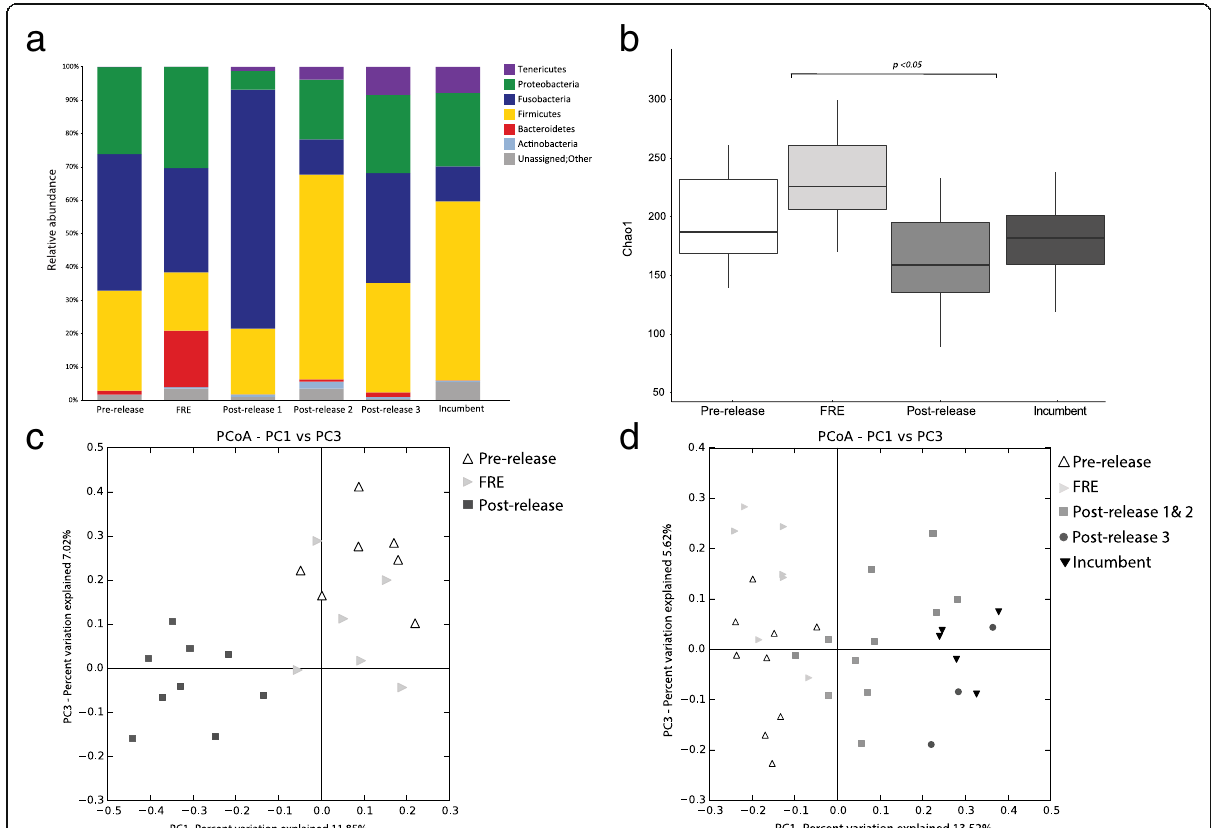
Fig. 3 Composition and diversity of gut microbiome of released ( n = 9) and wild incumbent devils ( n = 5) from the wild-to-wild translocation (Stony Head release) at various time points. a Bar chart showing the phylum-level composition of the gut microbiome; b Whisker-box plot showing the gut microbiome alpha diversity ( Chao 1 ) of released devils at each time point during translocation. Black horizontal lines are the median values; the lower and upper bound of boxes represent the 25th and 75th percentiles, respectively. Kruskal-Wallis test was used to calculate p values and evaluate significance of differences in alpha diversity; c Principal coordinates analysis (PCoA) plot based on the unweighted UniFrac distance matrix, depicting patterns of beta diversity from the gut microbial communities of Stony Head released devils at pre-release, the end of the free-range enclosure (FRE) period and post- release (early post-release; 1 – 3 months post-release). The PCoA plot shows clustering of the pre-release and FRE microbiome, as well as their separation from the post-release microbiome; d Principal coordinates analysis (PCoA) plot based on the unweighted UniFrac distance matrix depicting patterns of beta diversity from the gut microbial communities of released (Pre- release, FRE and Post-release 1 & 2 and Post-release 3), and wild incumbent devils at Stony Head (Incumbent). Post-release 1 & 2 represents samples collected at 1 to 3 months post-release, and post-release 3 represents samples collected 1 year post-release. Points that cluster together on the ordination have bacterial communities that are more